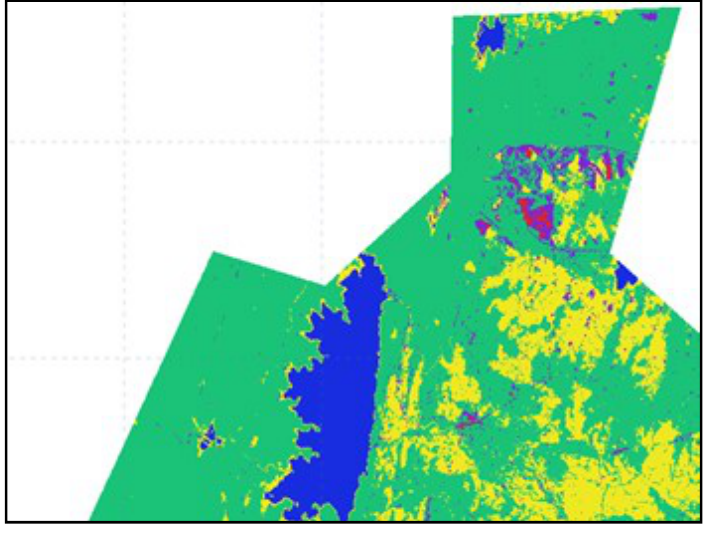
Figure 3.Agricultural Acerage Estimation, Sri